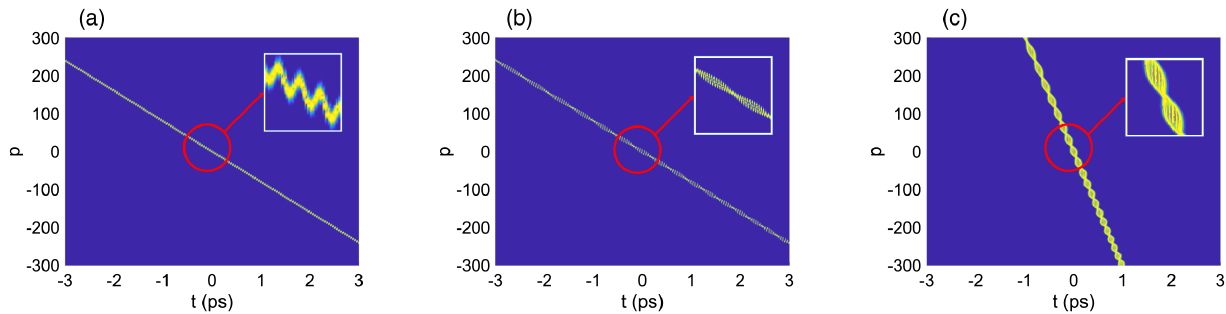
FIG. 3. Phase space evolution of the beam at different positions of (a) the exit of modulator1; (b) the exit of modulator2; (c) the exit of the second dispersion section. The head of the beam is on the right